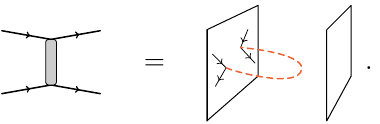
The AdS dual of the ungapped amplitude (2.2) is